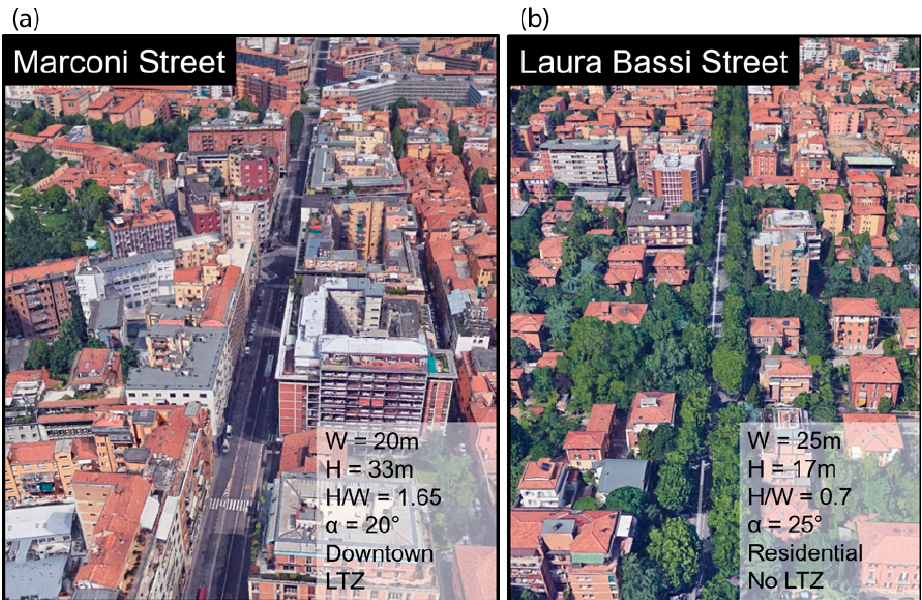
Figure 2. Street canyons views and details (W = mean street width, H = mean street height, α = orientation angle of the street canyon with respect to the meteorological north, LTZ = Limited Tra ffi c Zone) of the two street canyons in Bologna: ( a ) Marconi St.; ( b ) Laura Bassi St. (source: Google Earth).